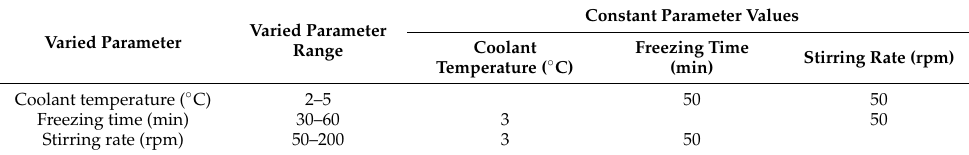
Constant Parameter